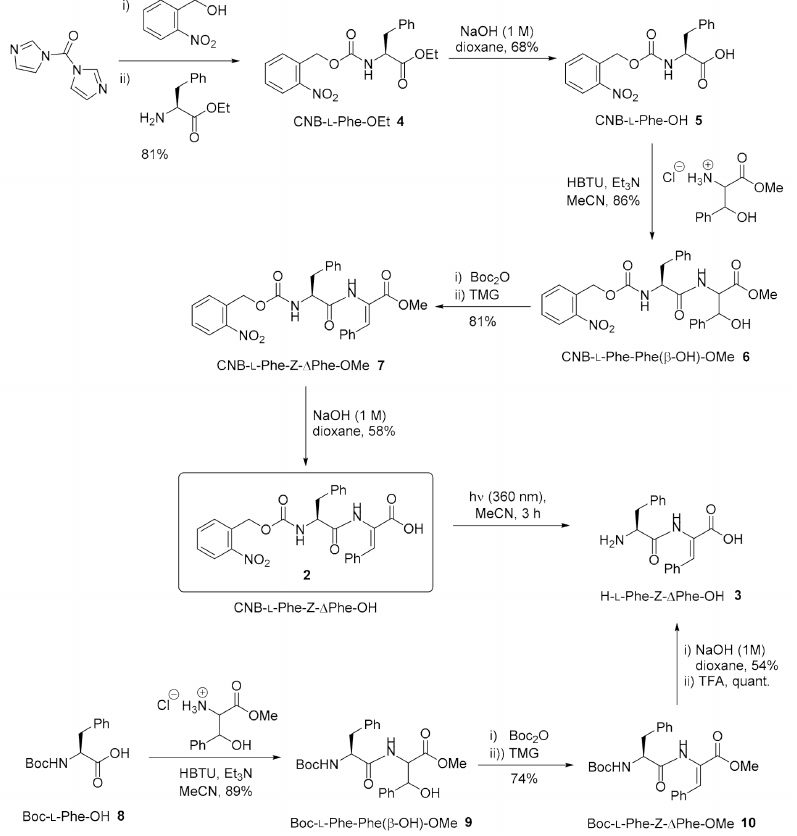
Scheme 1. Synthesis of CNB-Phe- ∆ Phe-OH ( 2 ) and H-Phe- ∆ Phe-OH ( 3 ). Irradiation with UV light converts ( 2 ) to ( 3 ). The C=C double bond in dehydroamino acid residues is present as the